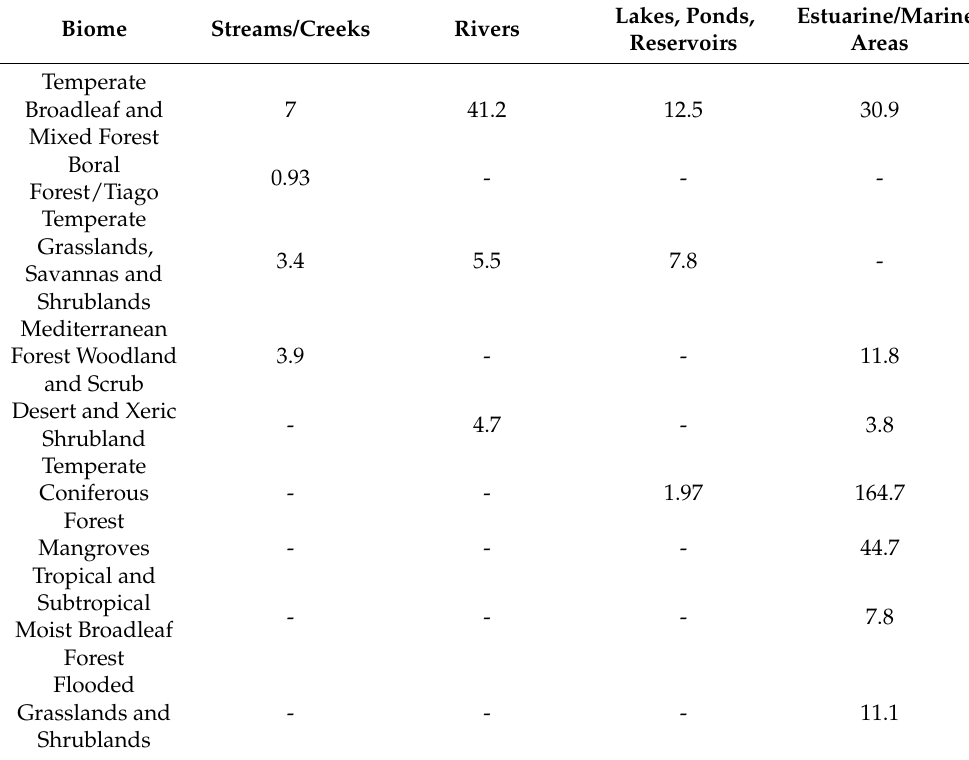
Table 7. Summary of AVS mean concentrations ( µ moles/g) by biome and waterbody type. Biome Streams/Creeks Rivers